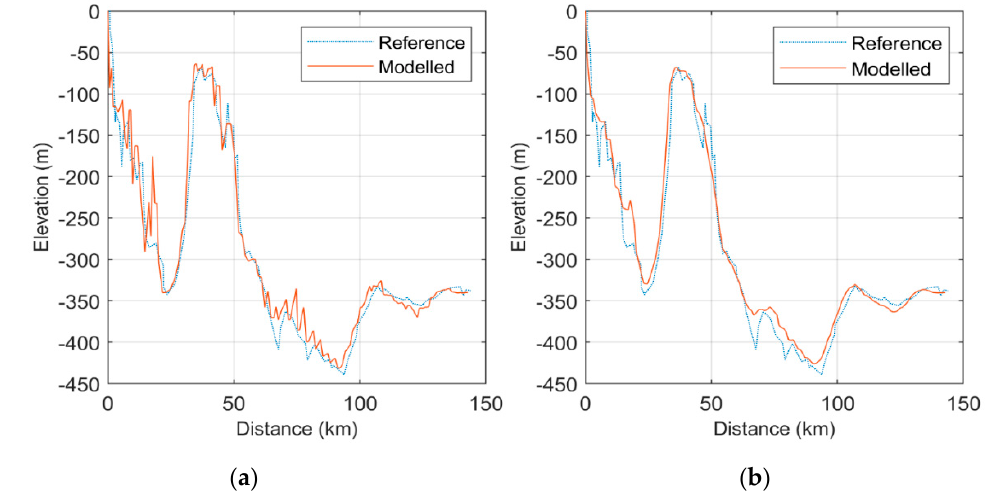
Figure 2. Elevation Profile Comparison Between Reference Data for Melkøya; [31] and ( a ) Modelled Profile with no Smoothing; ( b ) Profile with Smoothing.